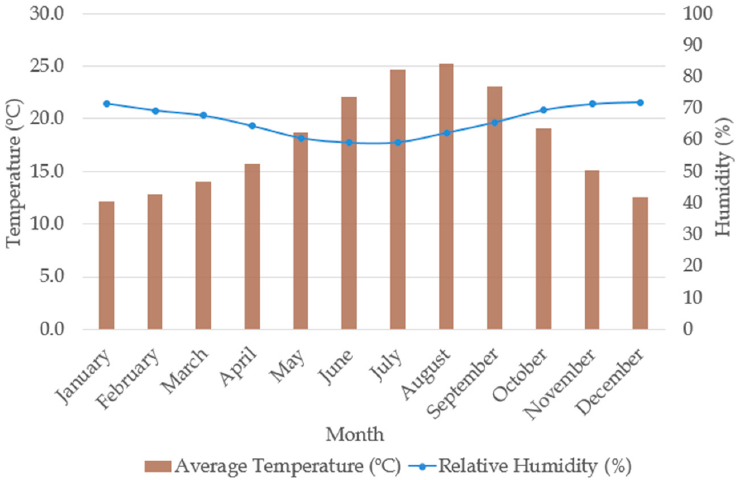
Figure 4. Monthly average temperature and relative humidity in historical scenario (1961–1990).